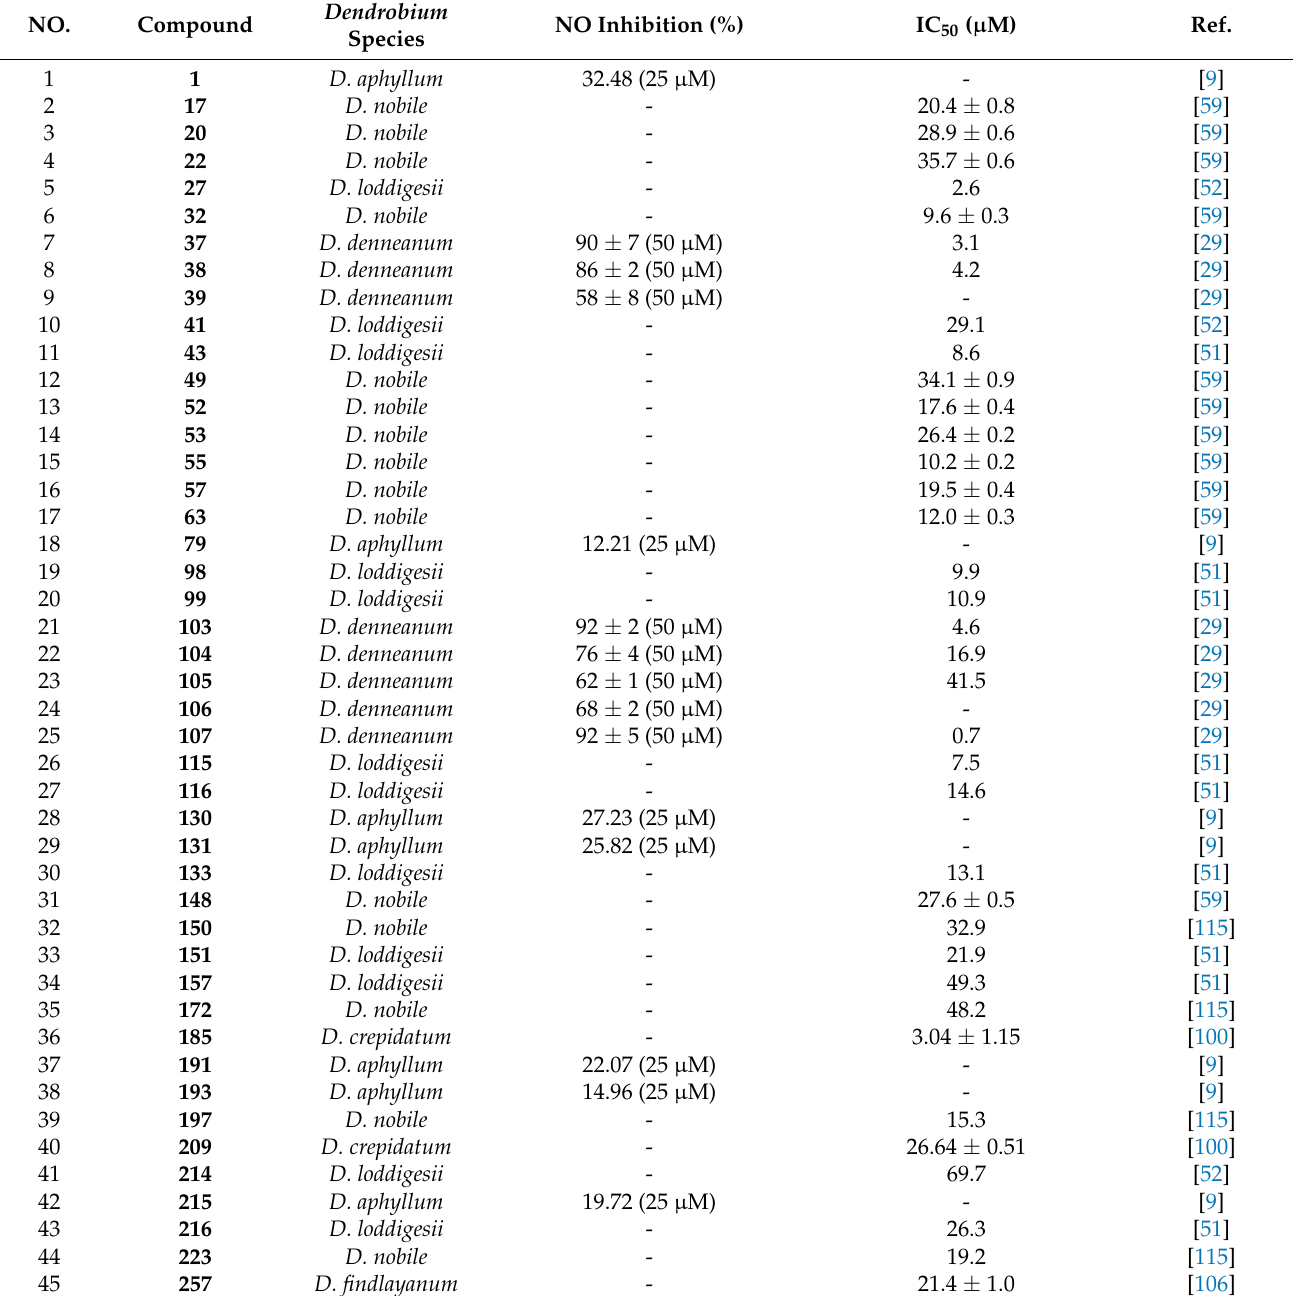
Table 4. Anti-inflammatory activity of stilbene compounds isolated from Dendrobium